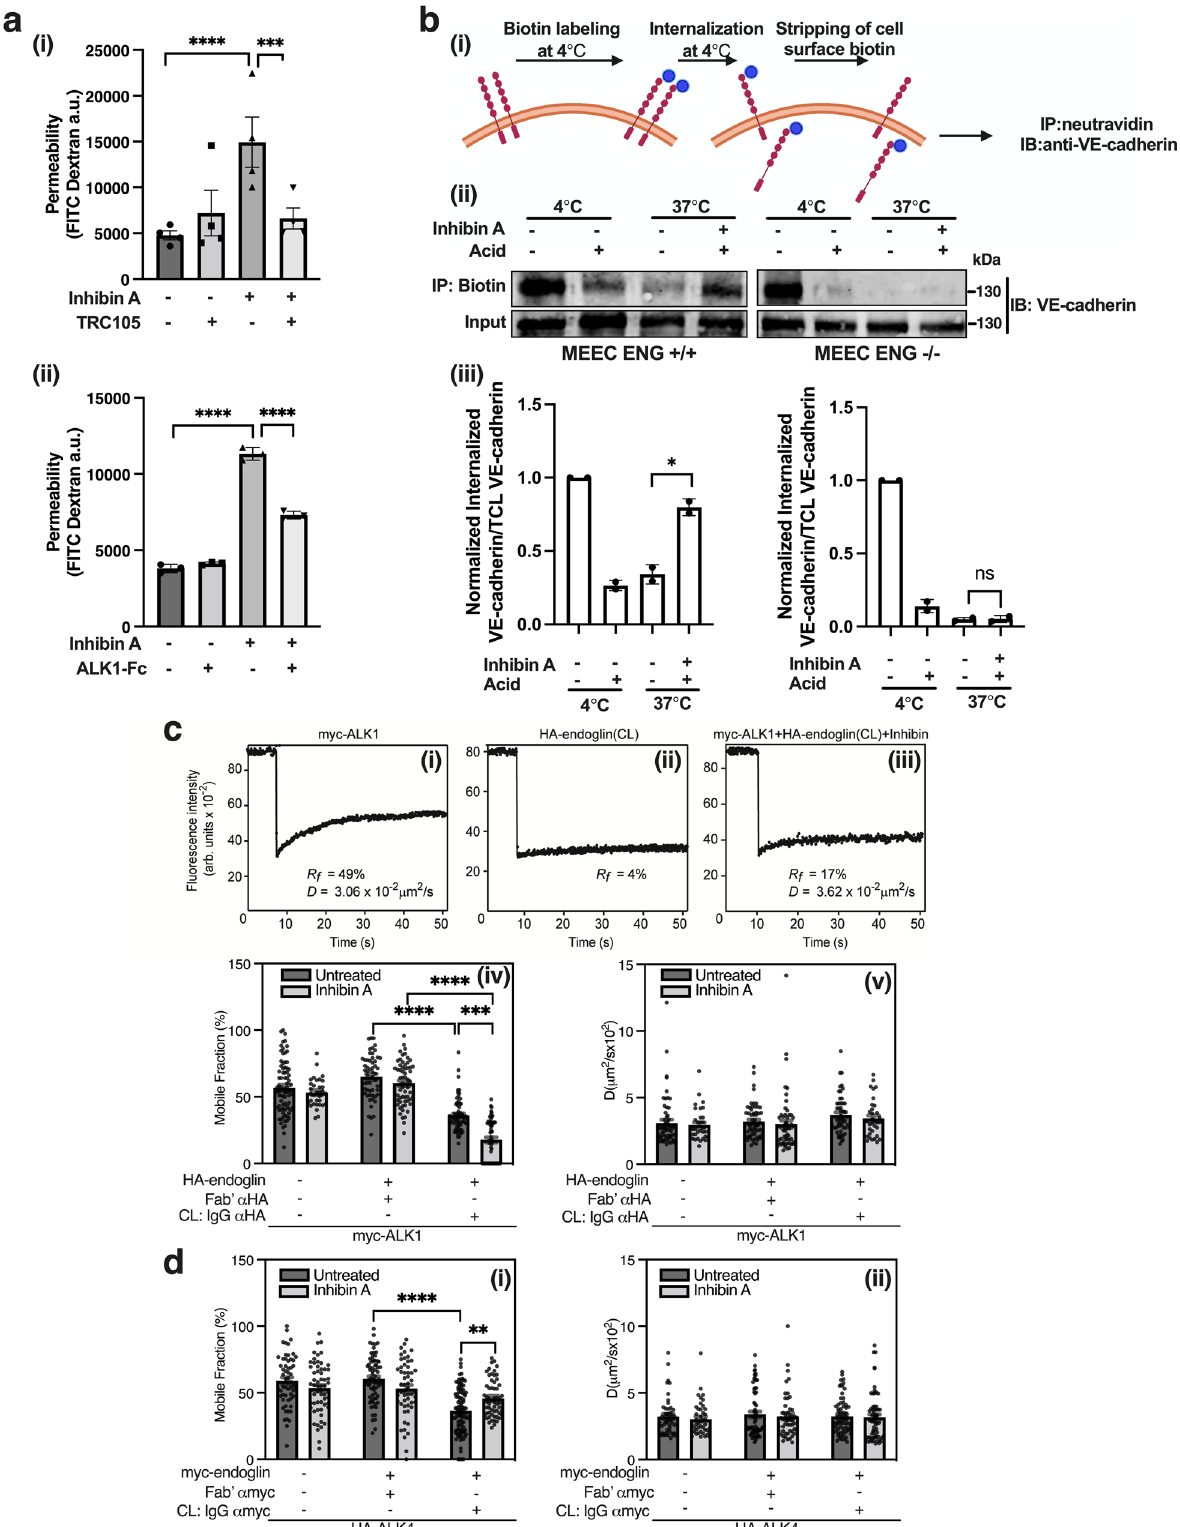
and tumors in all groups were harvested upon reaching 700 – 850 mm 3 (Fig. 7ci) to eliminate any tumor size effects on angiogenesis. These tumors (Fig. 7ci) were evaluated for changes in vascular permeability by visualization of a rhodamine-dextran dye that leaks from the blood vessels into the tumors when administered into mice prior to sacri fi ce. We fi nd